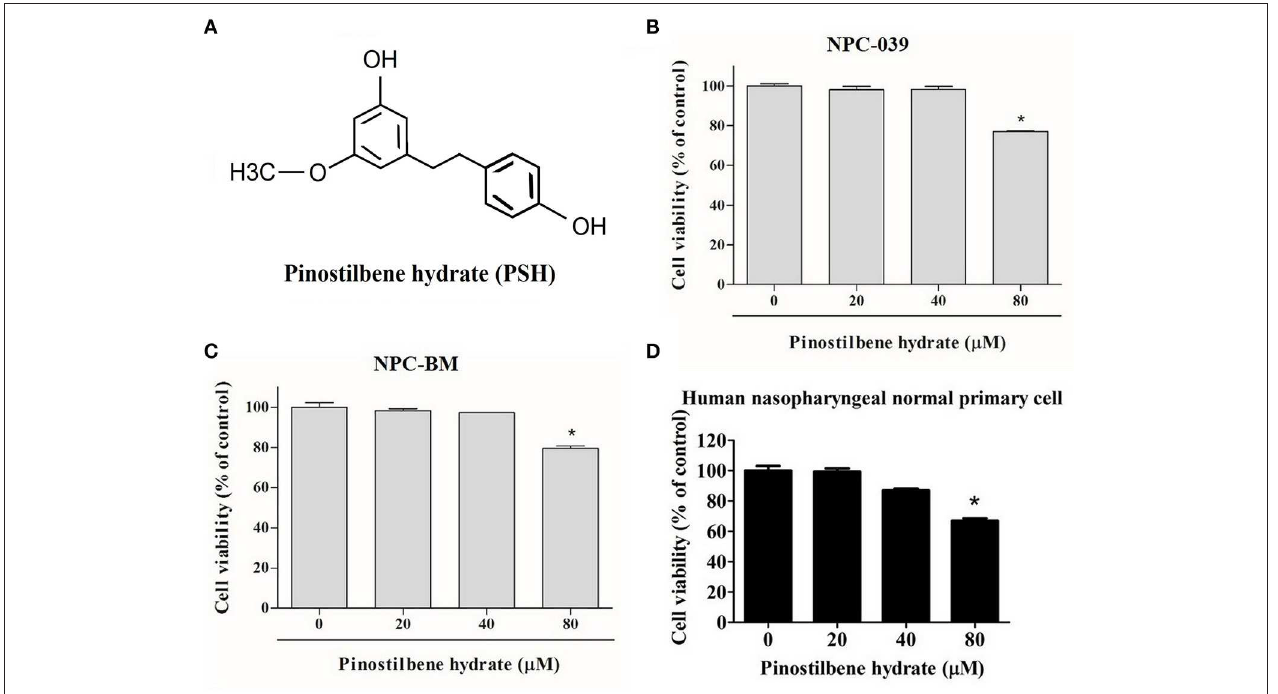
FIGURE 1 | Effects of PSH on the viability of human NPC cells. NPC-039 and NPC-BM cells were treated with various concentrations of PSH (0, 20, 40, and 80 µ M) for 24h. The cell viability was determined by MTT assay. (A) Chemical structure of pinostilbene hydrate (PSH). The cytotoxicity was observed on (B) NPC-039, (C) NPC-BM, and (D) human nasopharyngeal normal primary cell lines. PSH significantly inhibited the cell viability of NPC-039 and NPC-BM cells after treatment with 80 µ M of PSH. The values are the mean ± SD of at least three independent experiments. * p < 0.05.